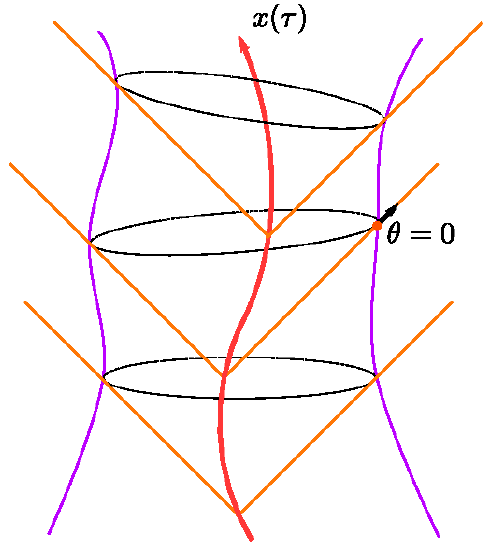
Figure 1 . A holographic screen can be constructed by null foliation from an observer’s light cones. For example, given an spacetime path x ( (cid:28) ), on each future lightcone emanating from that path, we can (cid:12)nd the maximal area codimension-two surface, if it exists. This surface will then have (cid:18) = 0 along the lightcone. Stitching together all these surfaces on all of the future lightcones associated with the observer will give us our holographic